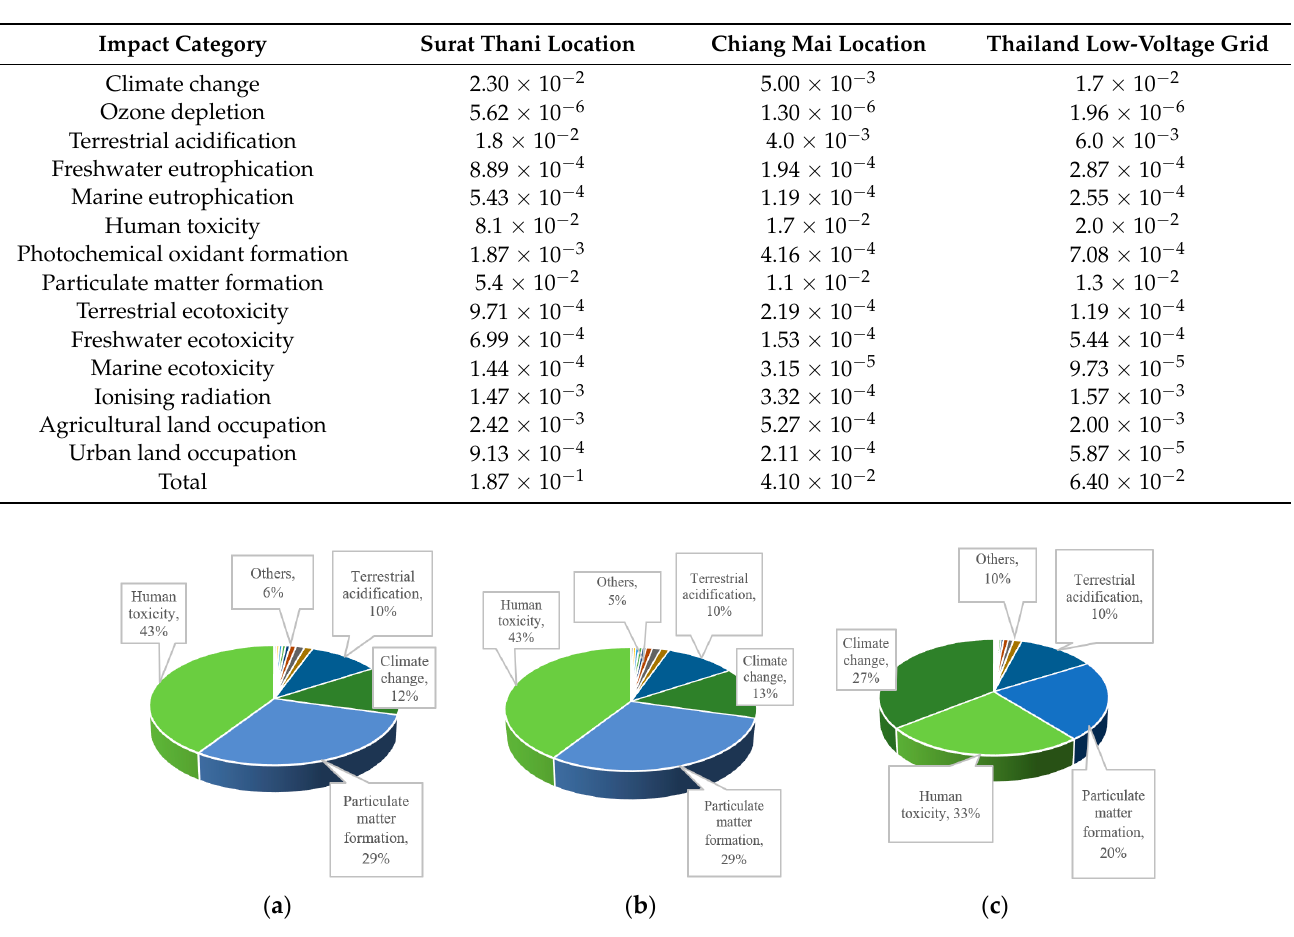
Table 9. Environment prices per impact (USD per kWh).